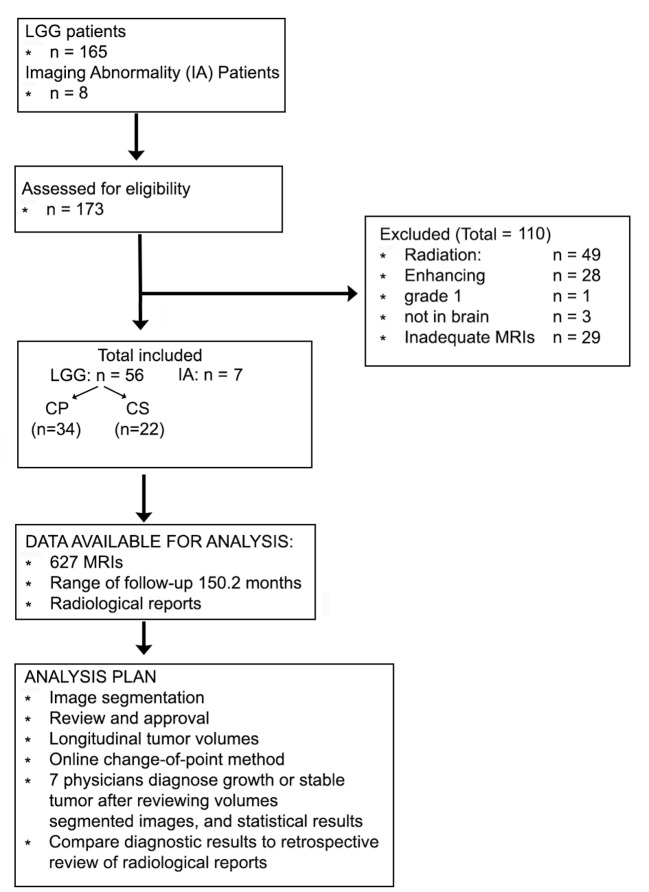
Flow diagram and analysis plan.CP, clinical progression; CS, clinically stable; LLG, low-grade glioma.